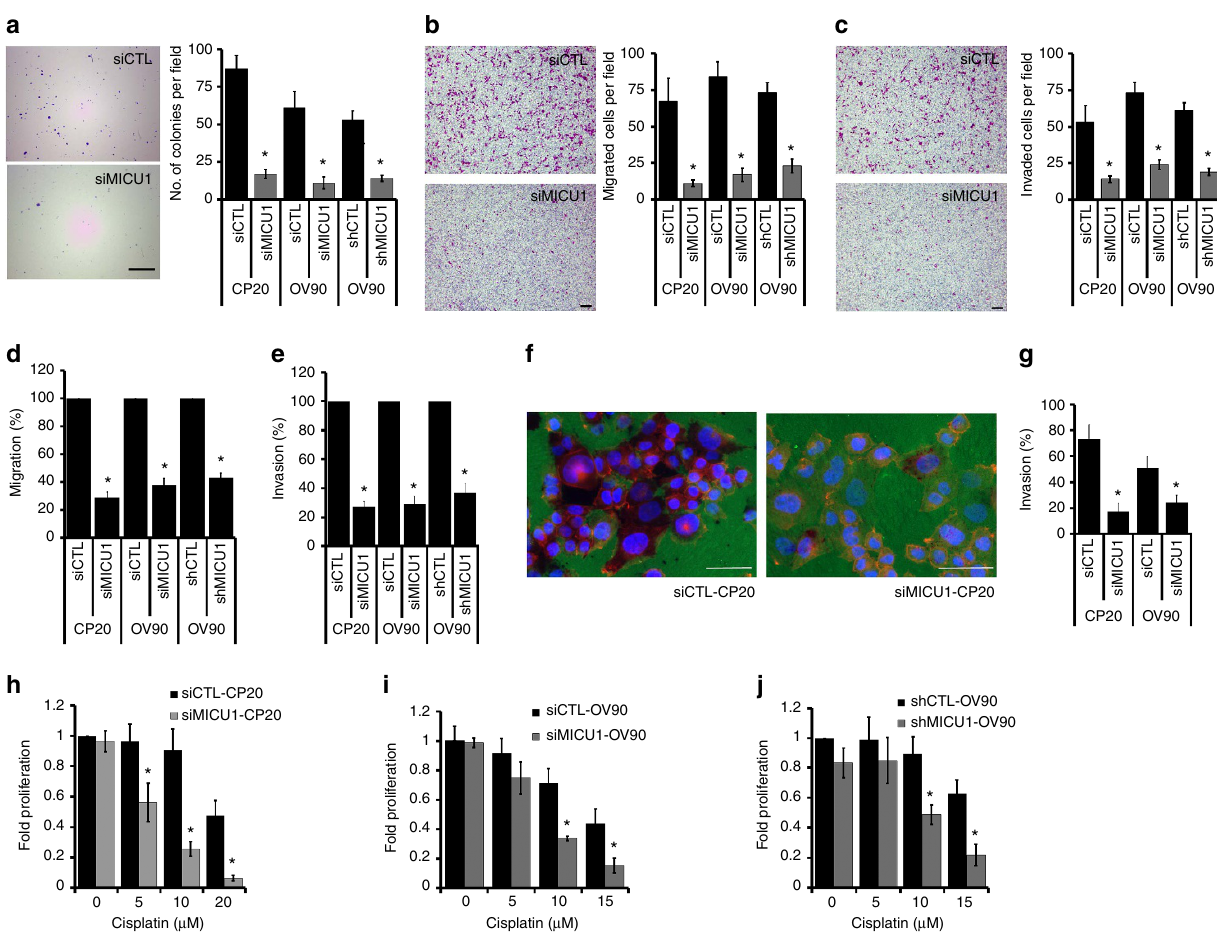
Figure 2 | Effect of MICU1 on cancer phenotypes. ( a ) MICU1 silencing affects clonal growth of OvCa cells. CP20 and OV90 cells were transfected with MICU1 siRNA or control siRNA and 48h after transfection cells were re-plated in 0.3% agar. Similarly, stable cell lines shCTL-OV90 and shMICU1-